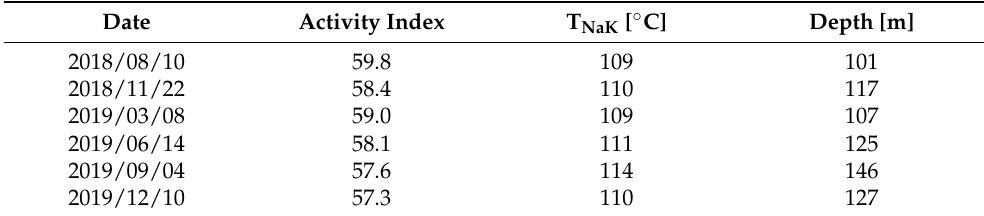
Figure 7. Na–K–Mg ternary relationships. Red circles indicate samples from Futamata hot spring. Table 5. Activity index, Na–K temperature, and aquifer depth, estimated from the activity index and Na–K temperature of Futamata hot